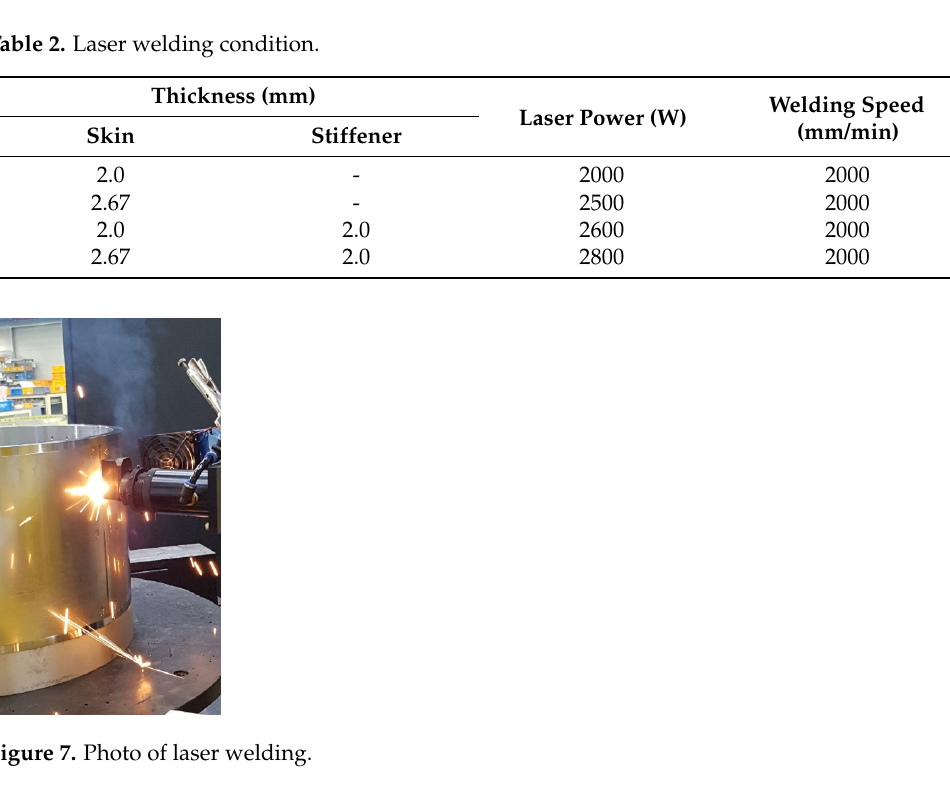
( b ) Figure 8. Cross-sectional macrograph of sti ff ener welding joints: ( a ) skin thickness: 2.0 mm + sti ff . thickness: 2.0 mm; ( b ) skin thickness: 2.67 mm + sti ff . thickness: 2.0 mm. 3.2. Deformation-Prevention Fixture and Welding Deformation Measurement Figure 9 demonstrates a jig con fi gured to induce tensile stress on the skin plate to prevent deformation. The jig is a straight structure, and grooves are installed on both ends to prevent interference with the sti ff ener on the back side of the welded part. Tensile stress is applied to the skin plate by rotating the screw installed in the centre of the jig to generate a forced displacement from the inside of the cylinder to the outside and elongate the jig. In the structure shown in Figure 9, two jigs are located across each other.